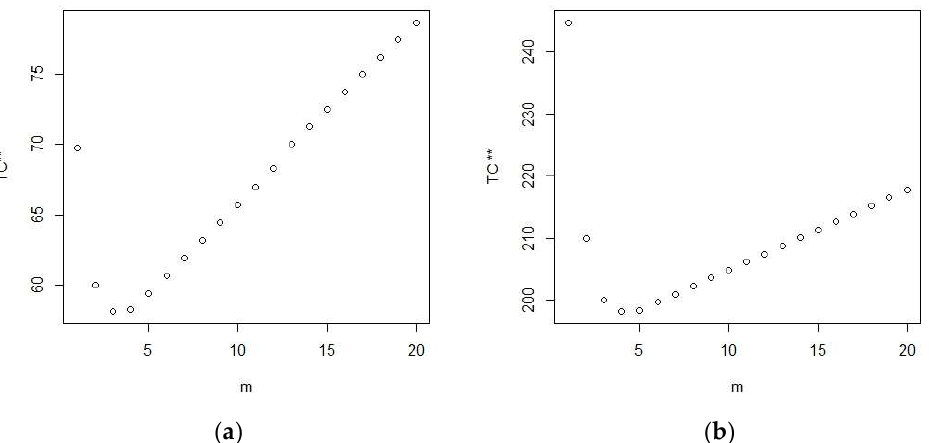
Figure 6. (a) Total cost curve at m = 1: m 0 for the first case; (b) Total cost curve at m = 1: m 0. for the second case.